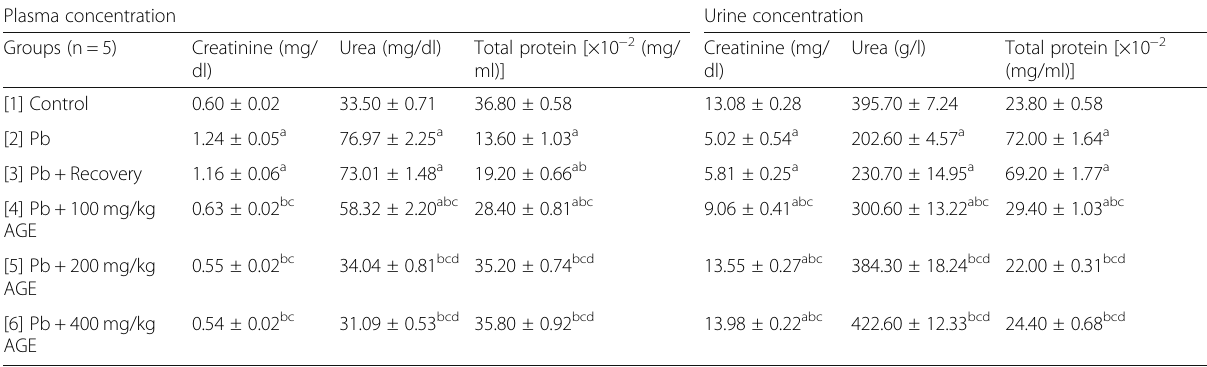
Table 6 Effects of AGE on plasma and urine concentrations of creatinine, urea and total protein in Wistar rats with Pb-induced kidney injury Plasma concentration Urine